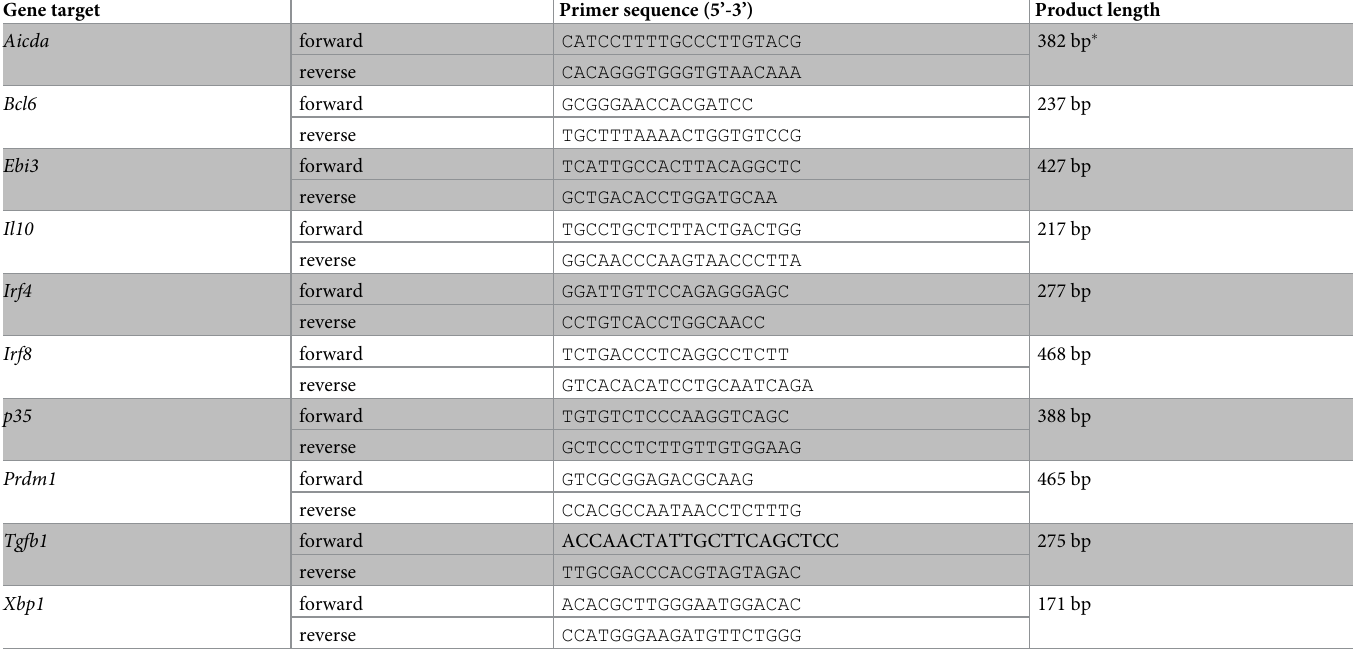
Table 1. qRT-PCR primers. Gene targets, forward and reverse RT-PCR primer sequences, and product lengths. Gene